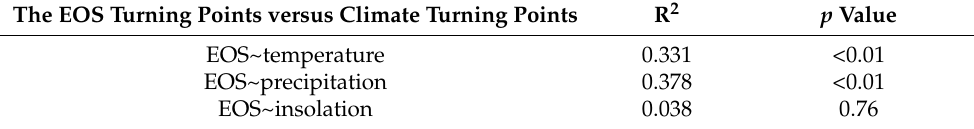
Table 2. Correlation coefficients and P values between the turning points of the EOS and the turning points of climate